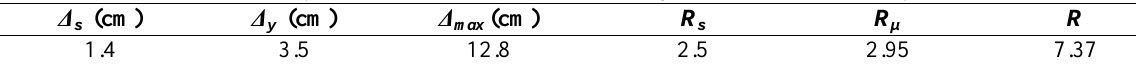
Table 6. Response modification factor for 5 story structure with non-deep